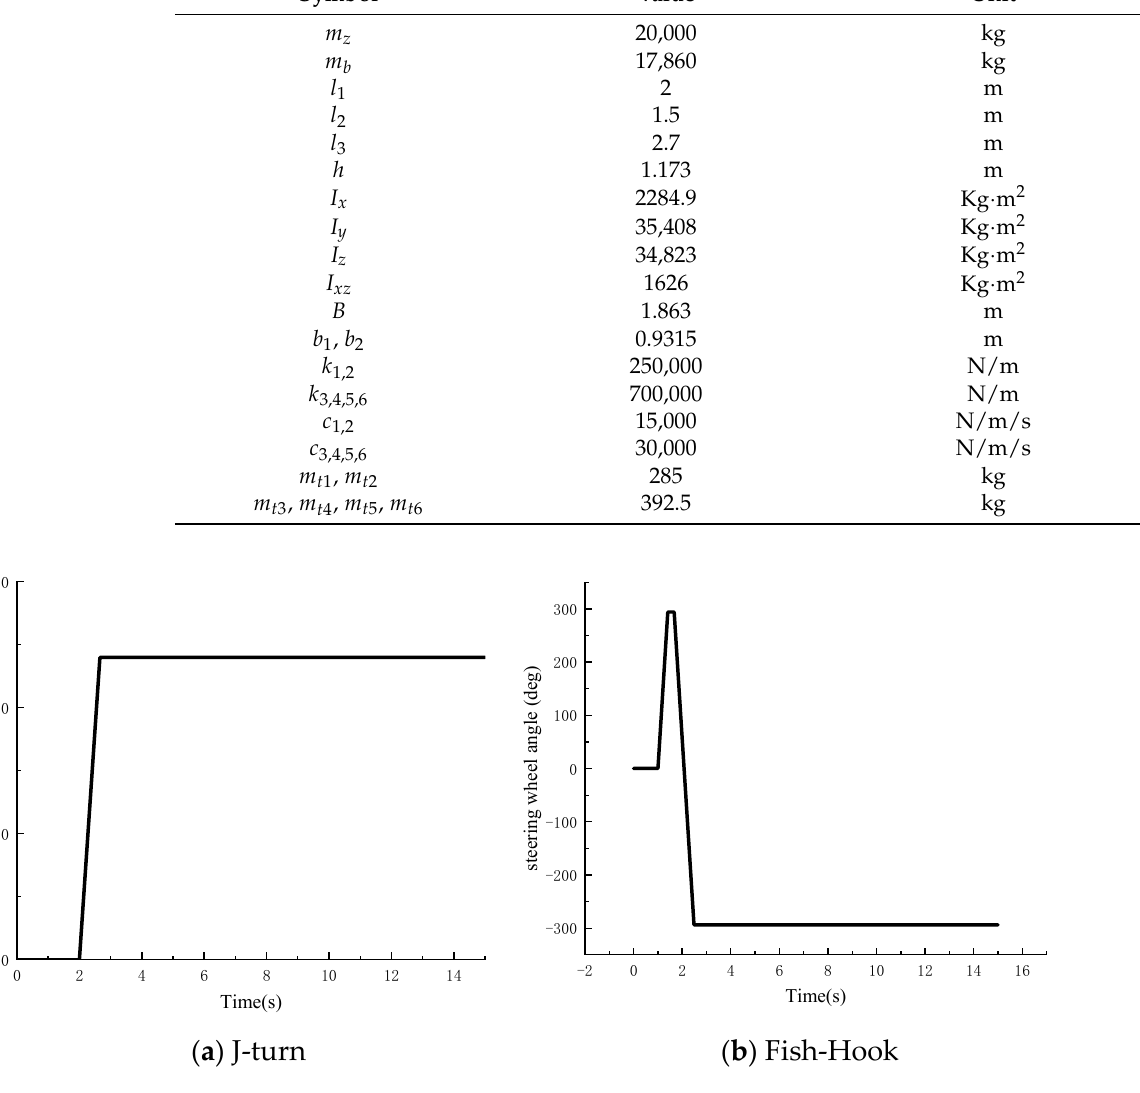
Figure 7. Steering wheel angle.